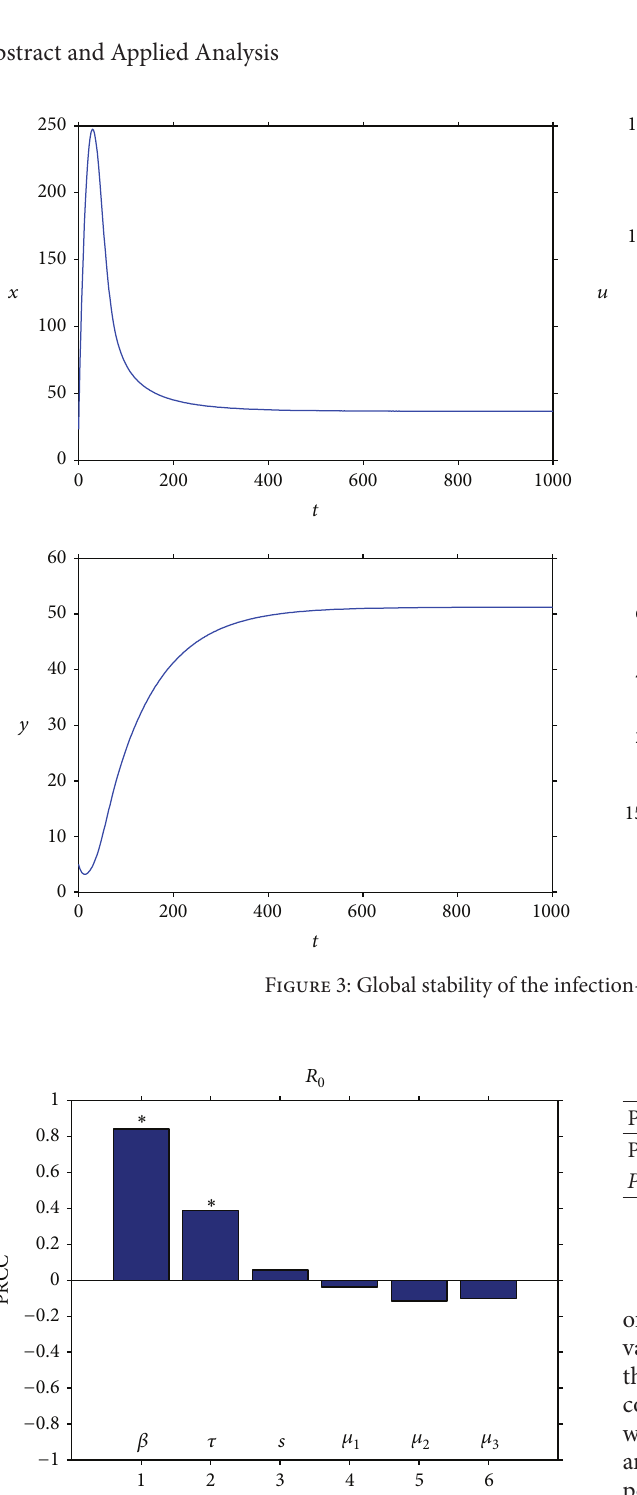
Figure 4: Sensitivity analysis of 𝑅 0 with the parameters came from LHS sampling.